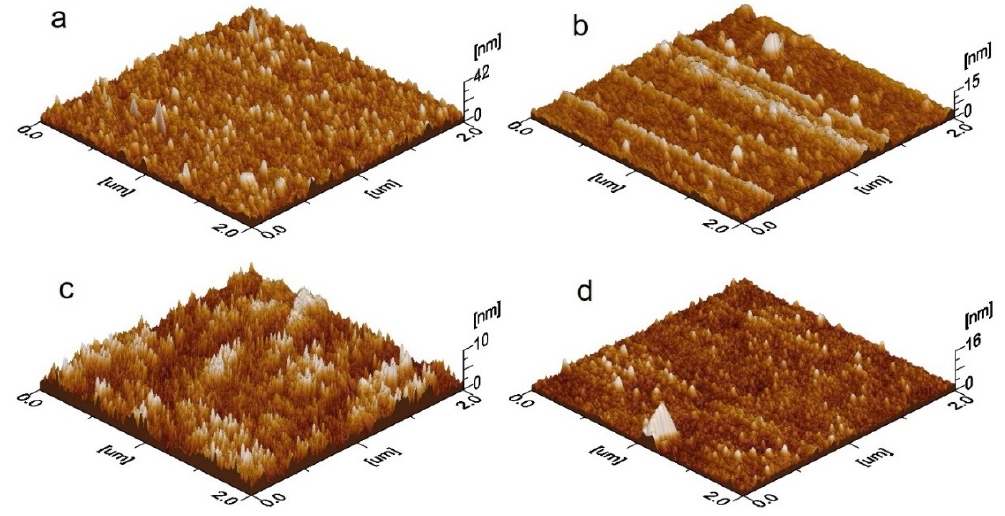
Figure 3. 3D AFM surface topographies of the metal‐doped ZnO thin films after annealing: ( a )